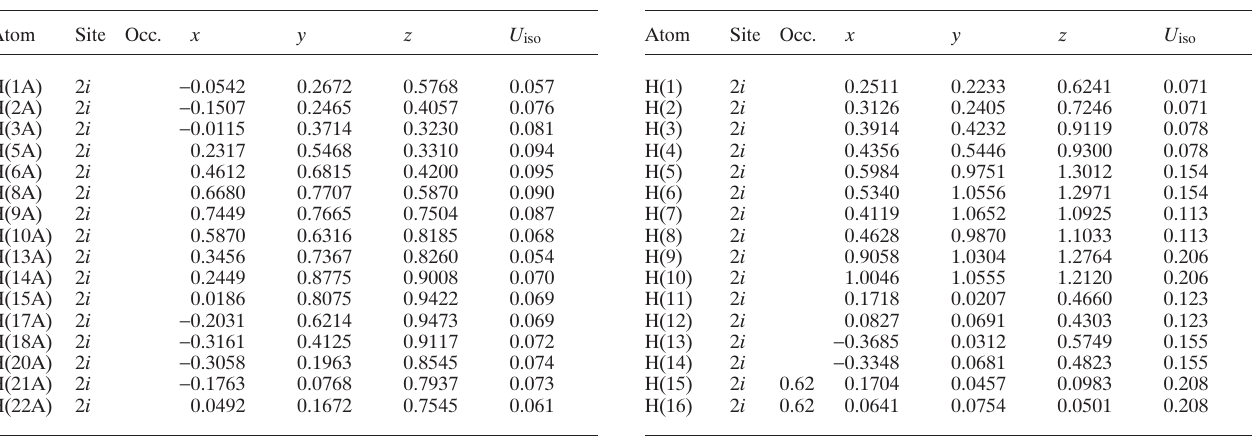
Table 2. Atomic coordinates and displacement parameters (in Å 2 )